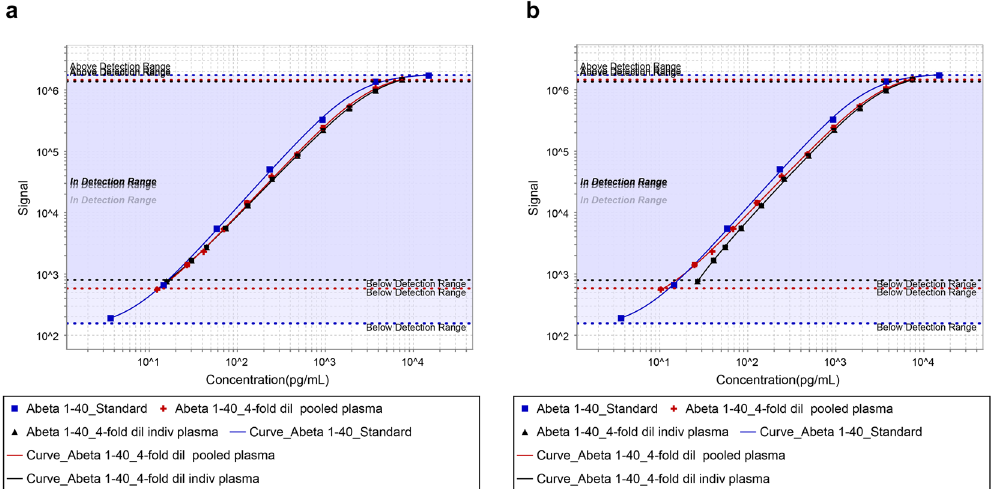
Figure 3. Comparison of signal response curves incorporating endogenous A β 40 concentrations determined by relative quantification and linear regression. The signal response for the conventional calibration curve (blue curve) and the spiked plasma curves: i.e. 4-fold diluted plasma samples (both the pooled plasma (red curve) as well as the individual plasma A07 (black curve)) were plotted against the total analyte concentration incorporating the endogenous A β 40 concentration derived ( a ) by relative quantification by interpolating from the standard curve using the MSD software, and ( b ) by using linear regression.